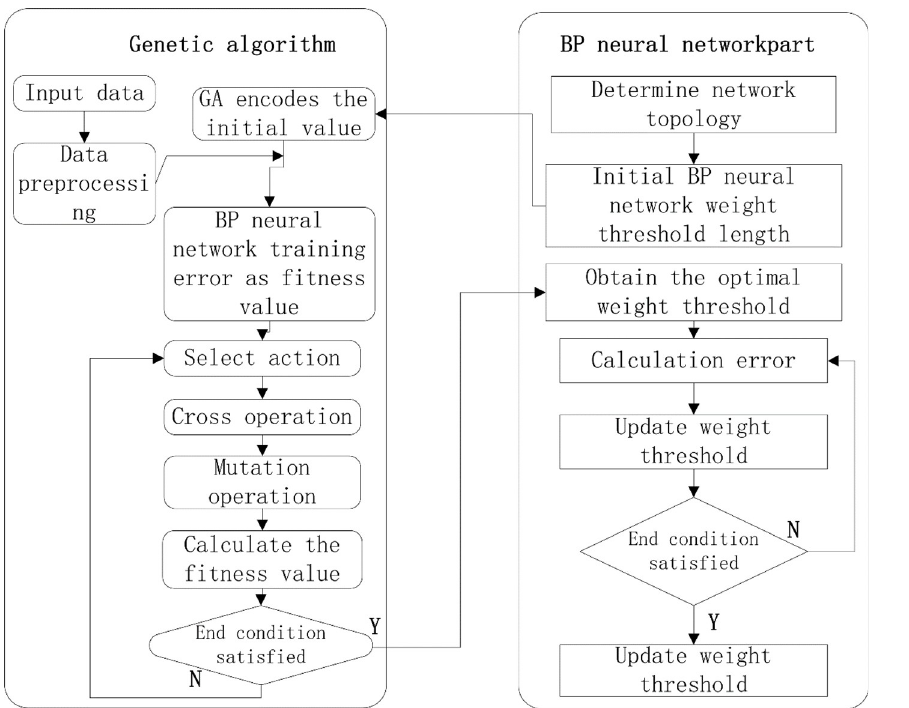
Fig 15. Flowchart of the GA-optimized BPNN algorithm.